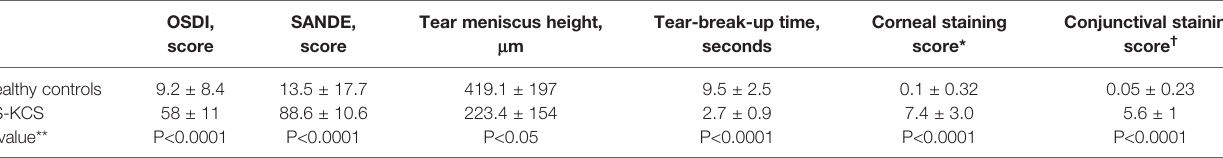
TABLE 2 | Summary of clinical data, showing mean ± standard